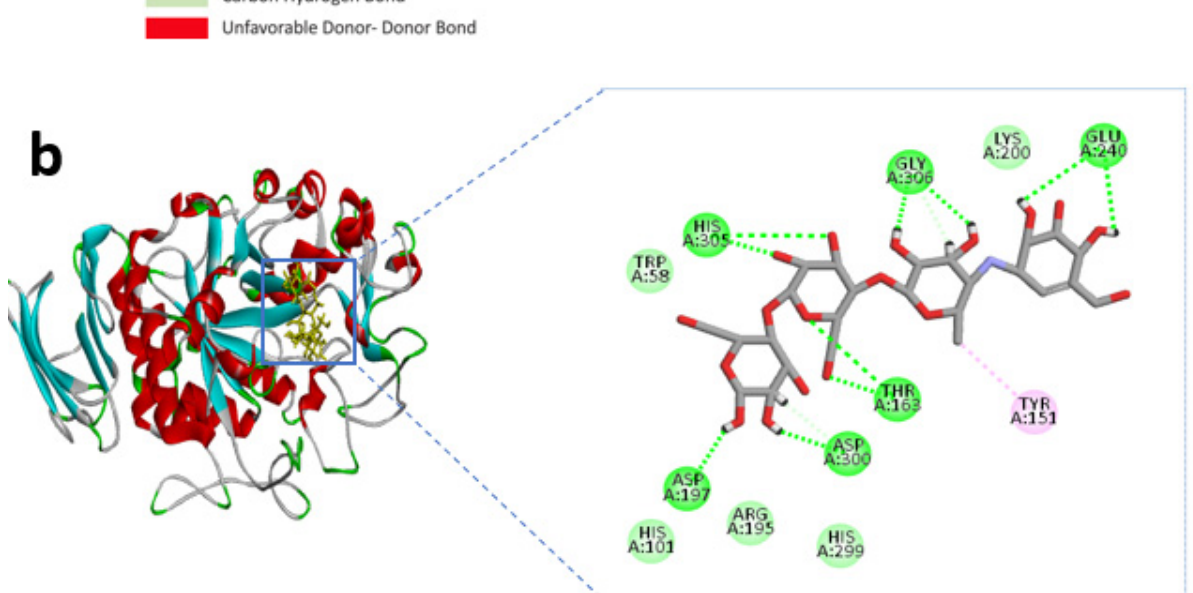
Figure 1. Molecular interactions of the selected compound with alpha-amylase, ( a ) apigenin-7- O - glucoside with alpha-amylase, ( b ) control acarbose with alpha-amylase.